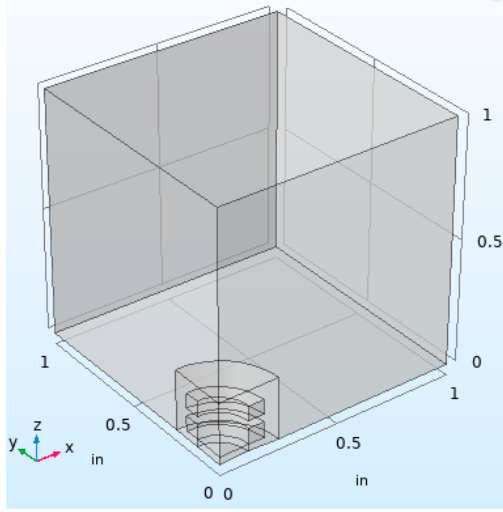
Figure 4. Reduced FEA simulation volume.